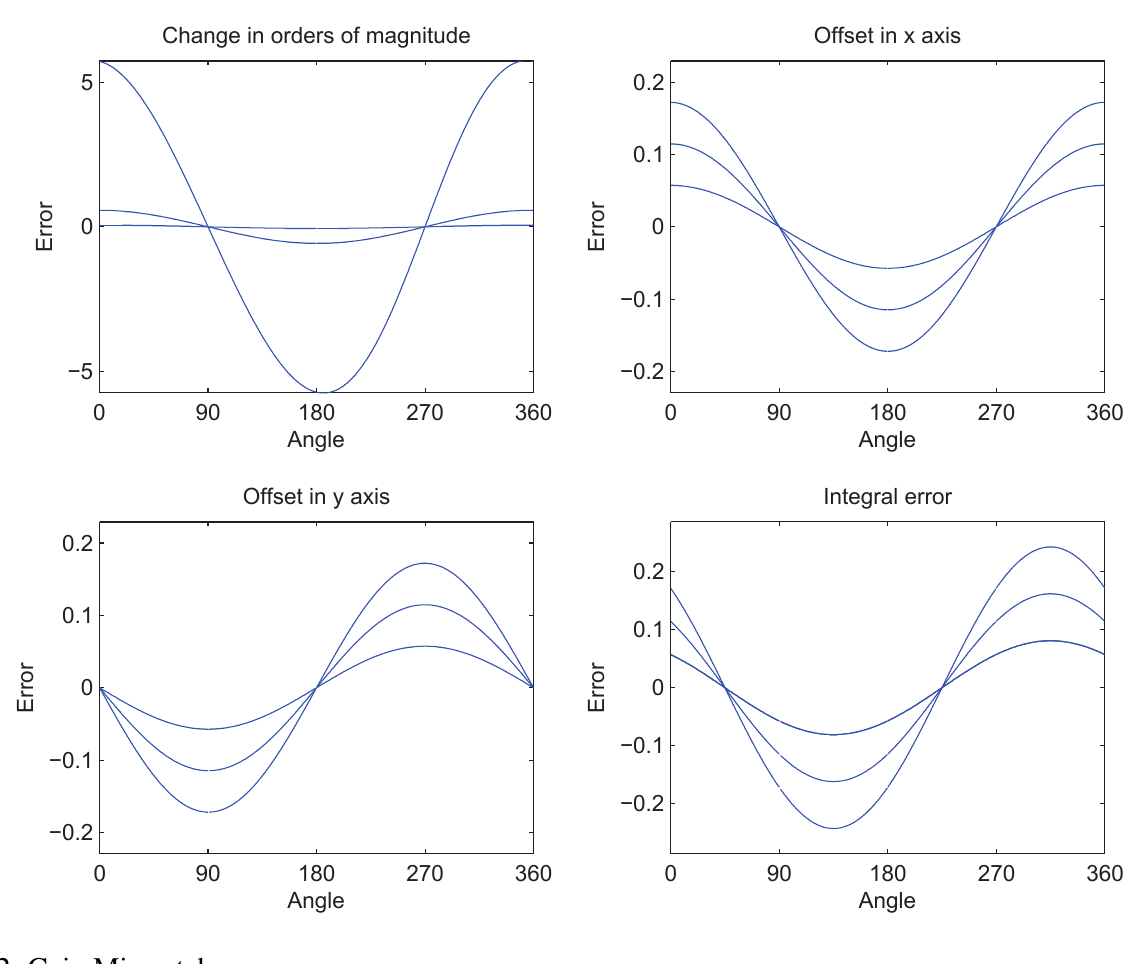
Figure 3. The angle error curves in different offset